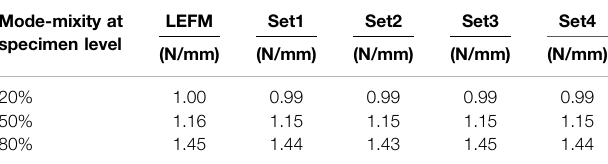
TABLE 4 | Fracture toughness of interface output from different simulation